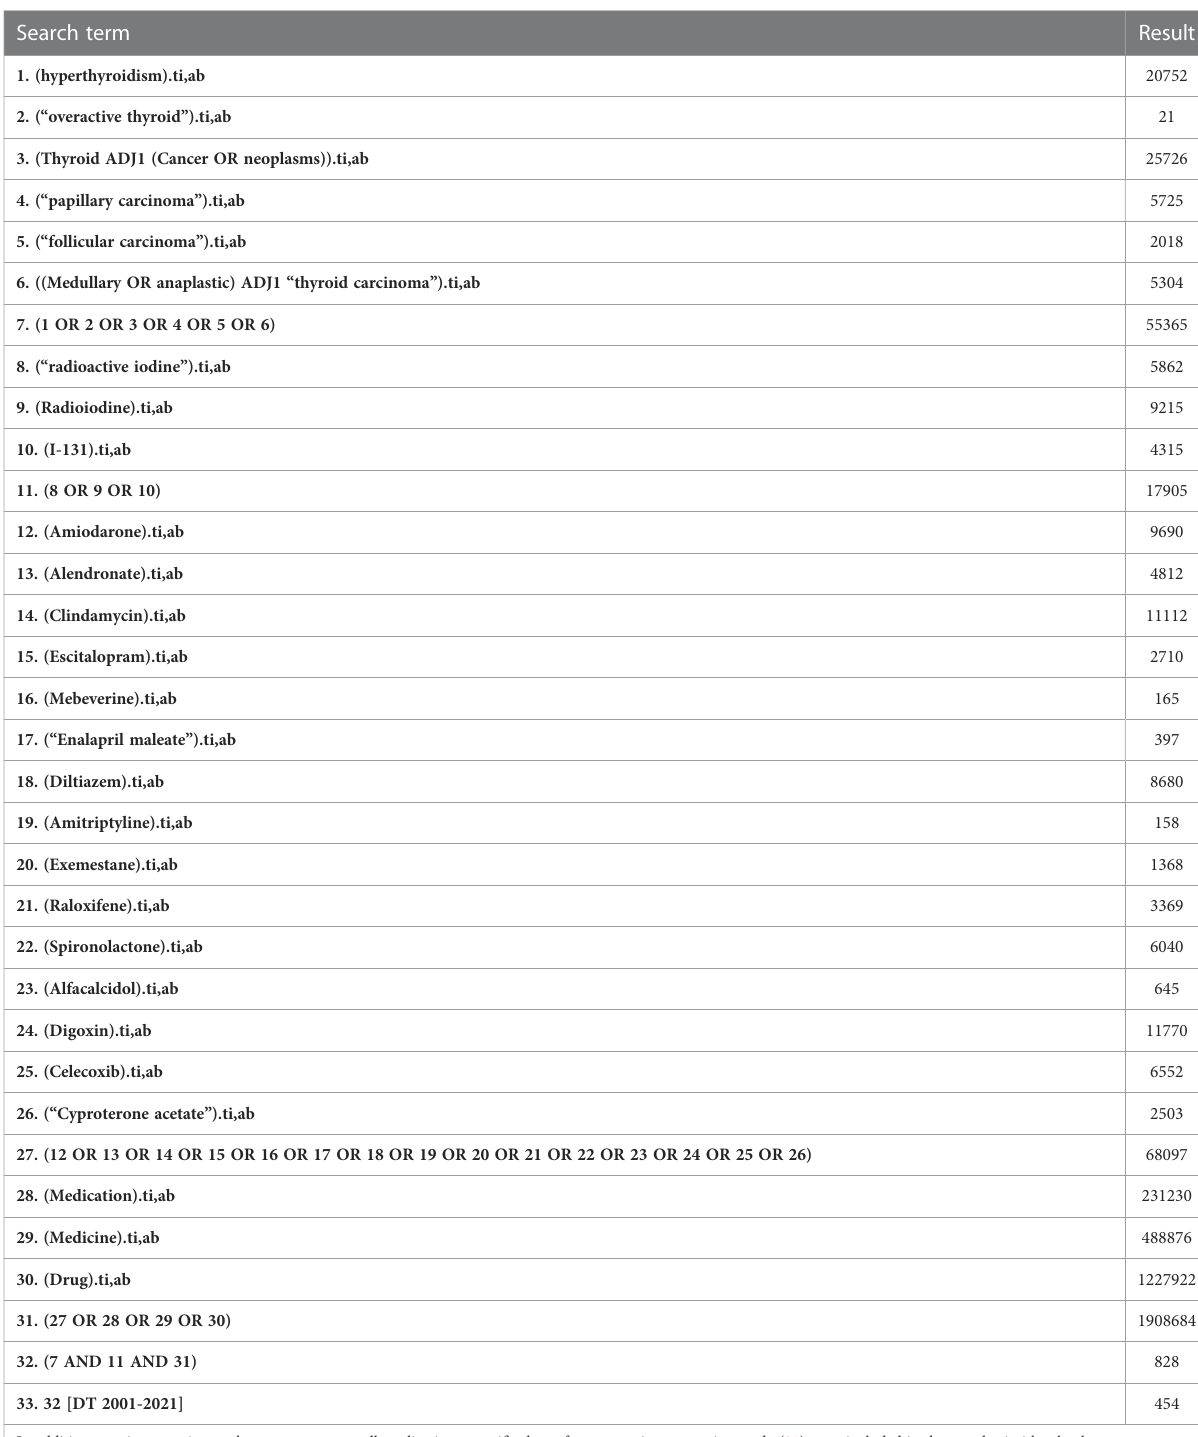
TABLE 1 Search strategy on MEDLINE for records published between 2001 and